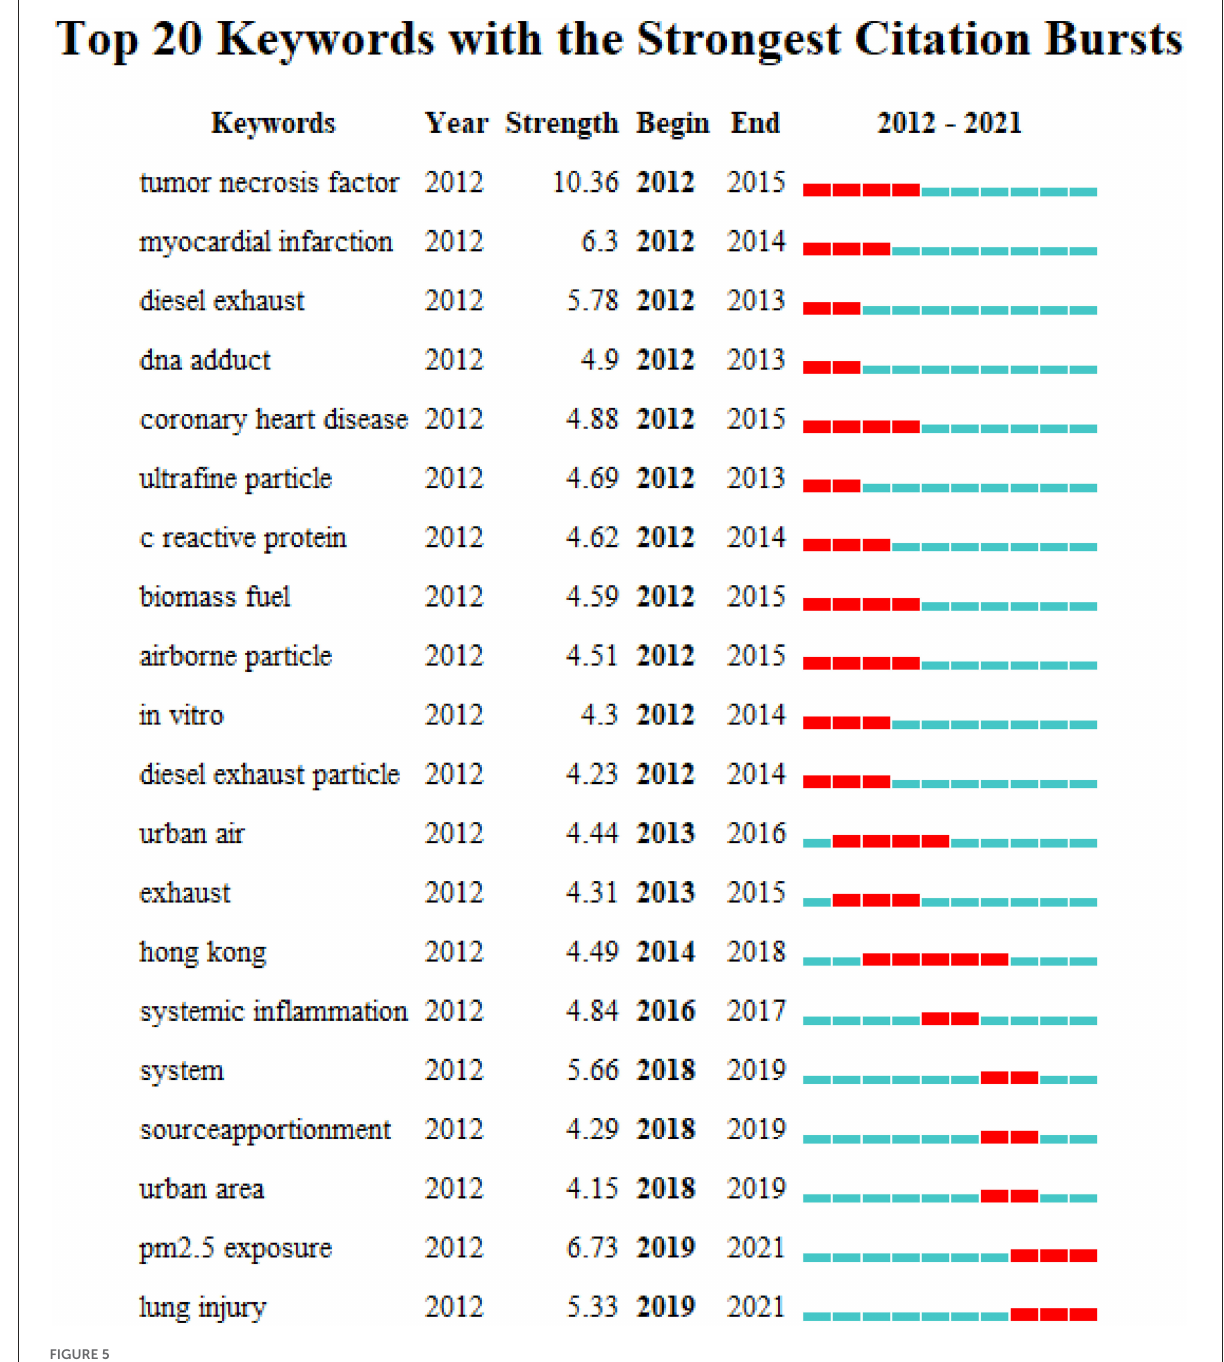
FIGURE5 Top 20 keywords burst map by